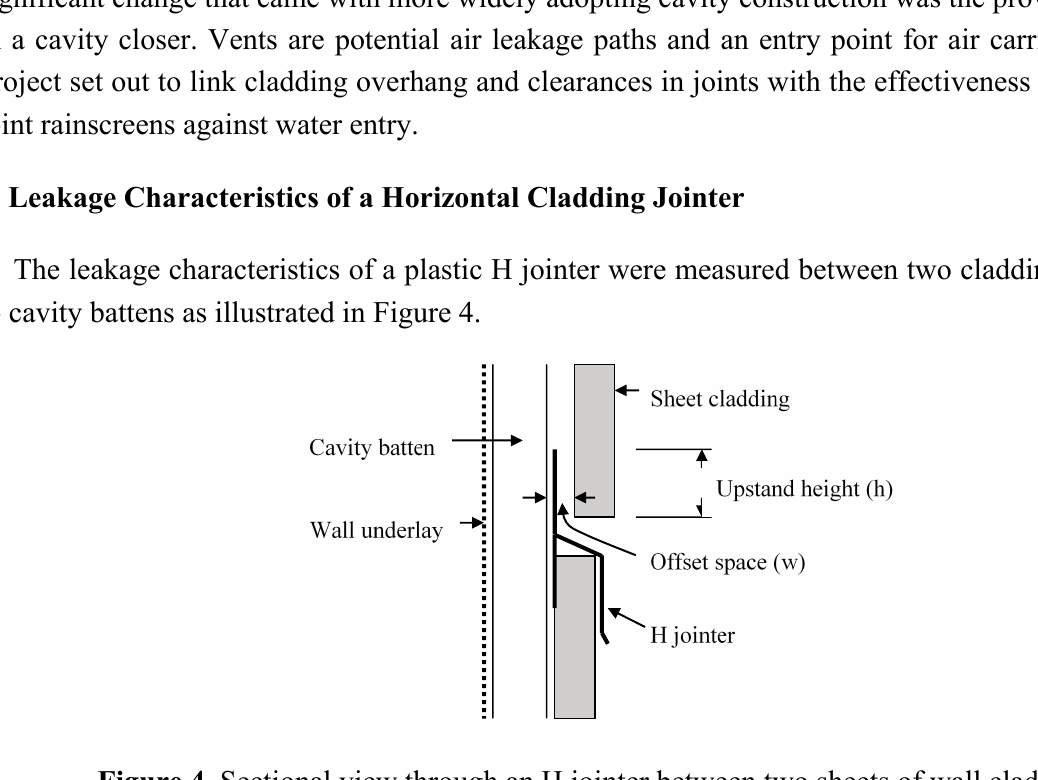
Figure 4. Sectional view through an H jointer between two sheets of wall